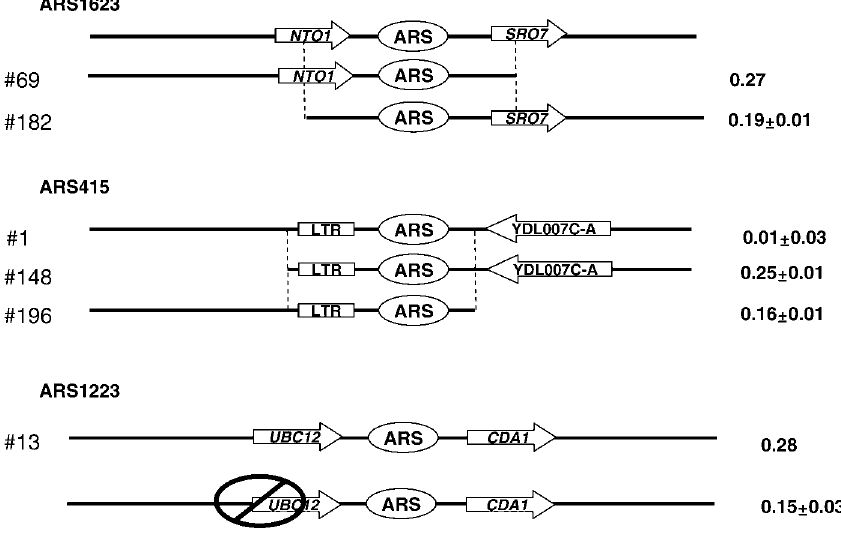
Figure 4. Effect of Local Transcription Pattern on Plasmid Stability Three sets of deletion plasmid constructs and their corresponding loss rates in mcm1–1 cells are shown. DOI: